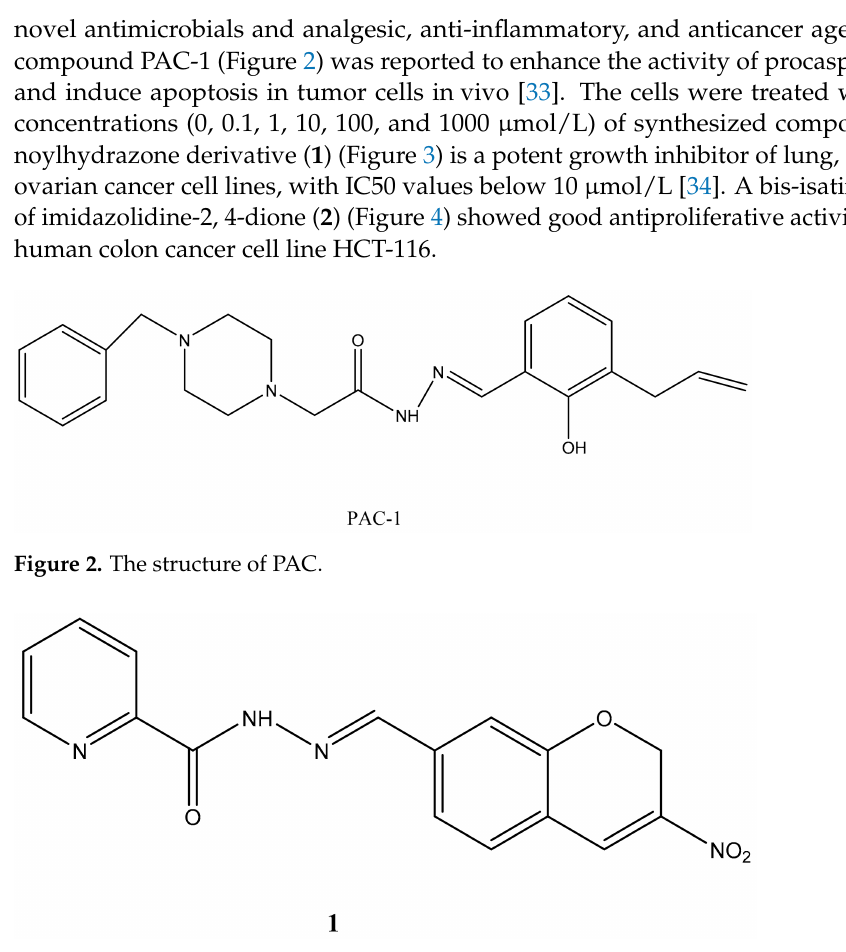
Figure 3. The structure of 1 . (IC50 = 8.07 µ mol/L, A549; IC50 = 0.76 µ mol/L, KG-1; IC50 = 0.18 µ mol/L, A2780).